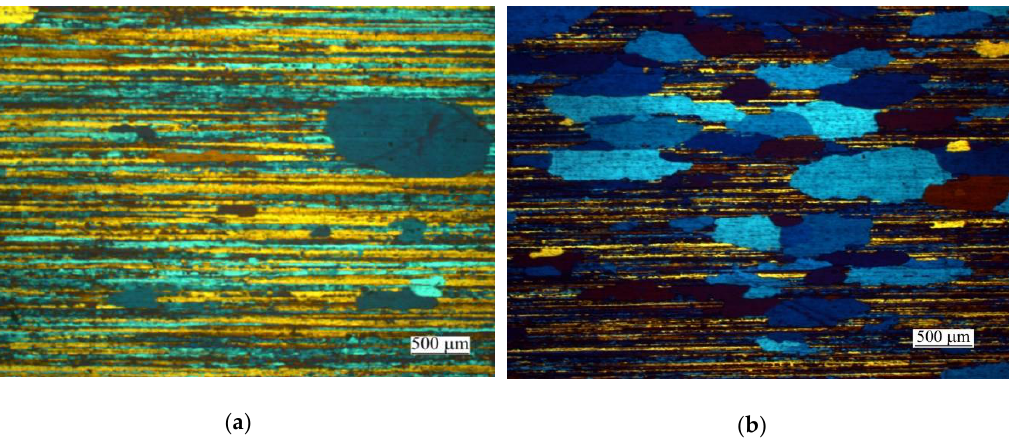
Figure 4. Polarized light optical micrograph of AA 1050 after ( a ) direct extrusion and ( b ) annealing for 20 h, at 300 °C, following direct extrusion.